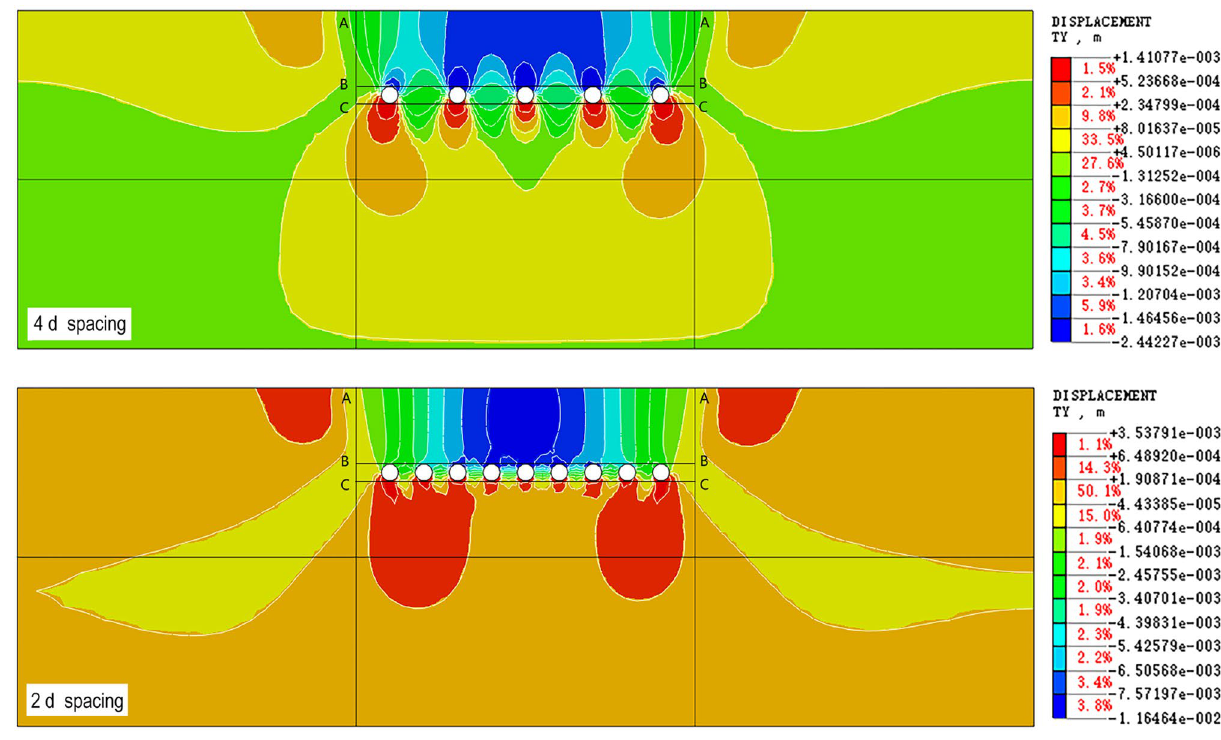
Fig. 8 Comparison of the vertical displacements at 4 d and 2 d spacing